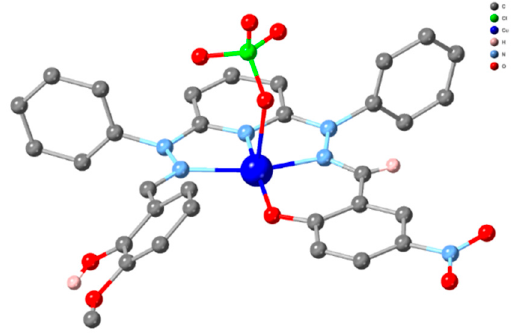
Figure 4. The crystallographically characterised pre-catalyst compound 11 .